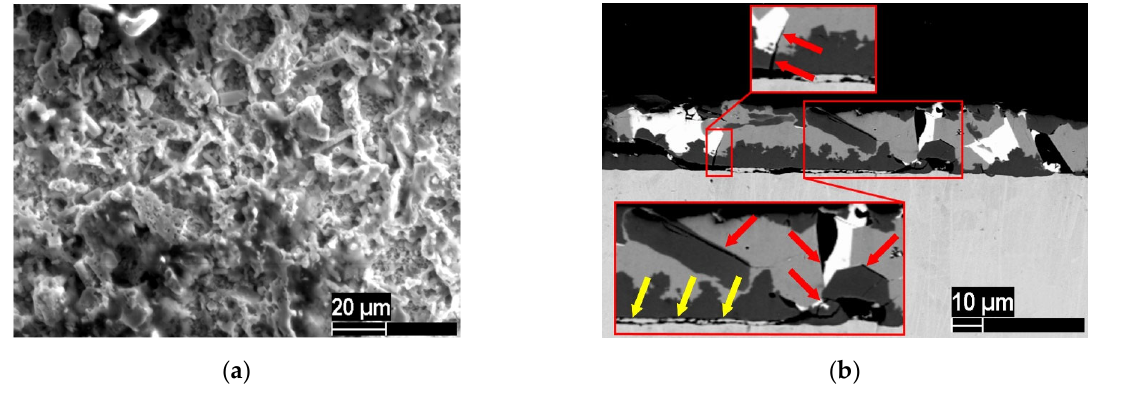
Figure 18. SEM images of the AISI 304/AISI 304 joint brazed according to the 540 ◦ C/30 min mode. Different fracture views at 1000 × magnification: ( a ) surface fractogram; ( b )